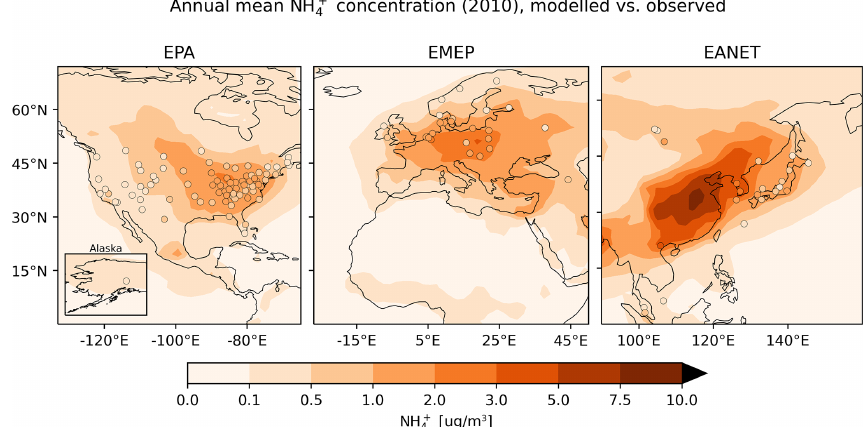
Figure 26. The same as Fig. 21 but for NH +